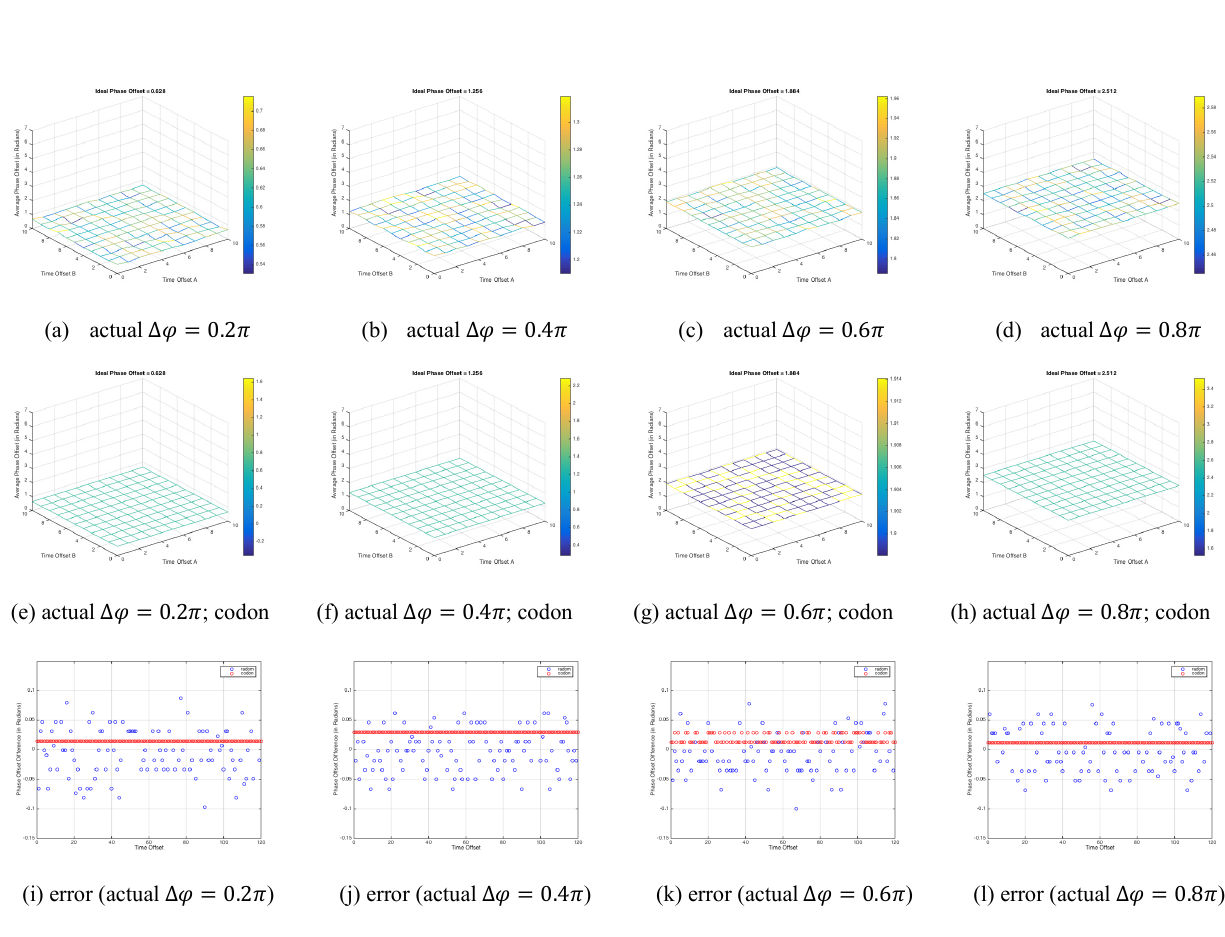
Fig. 10. Phase Offsets of Average-RSS-Time Curves with Different Time